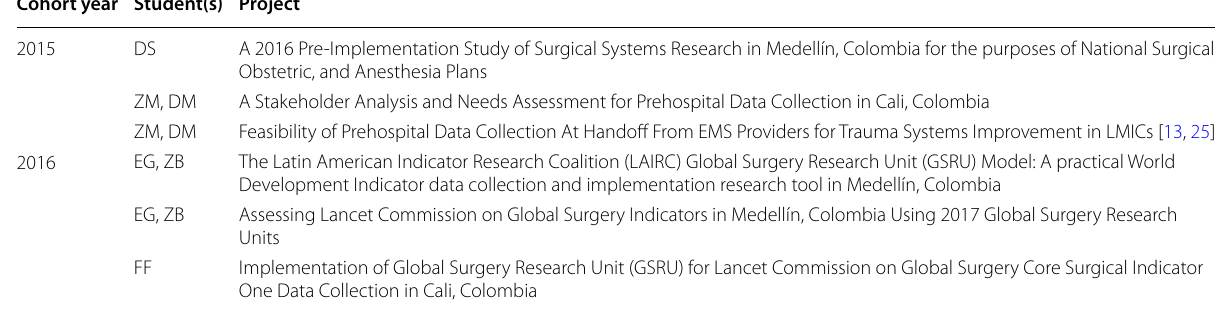
Table 3 List of projects produced by the students of the 2015 and 2016 cohorts Cohort year Student(s) Project 2015